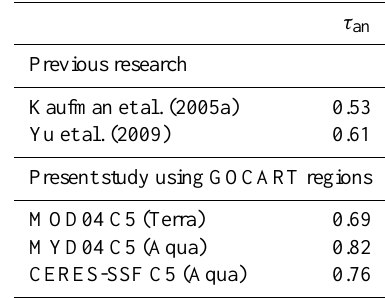
Table 3. Anthropogenic AOT ( τ an ) derived using the FMF statistics from Kaufman et al. (2005a), Yu et al. (2009), and our Aqua and Terra estimates. Assumptions include an observed unit AOT ( τ =